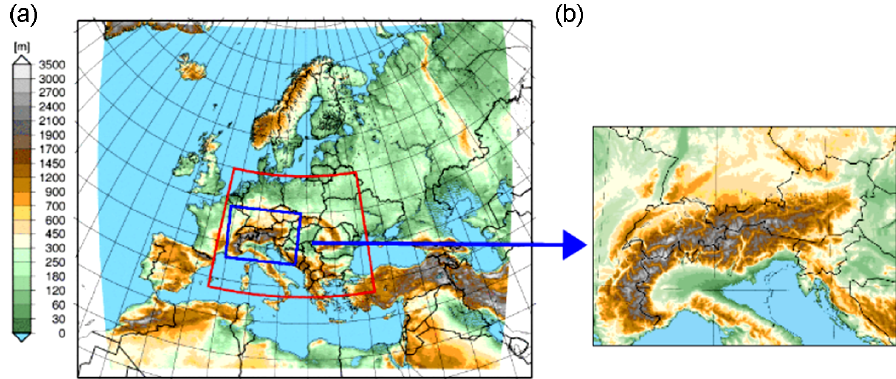
Figure 1. Geographic domains and topographies of (a) ALADIN-LAEF, where the red frame is the output domain used for the present study, and (b) AROME-EPS, which is shown by the blue frame in (a)